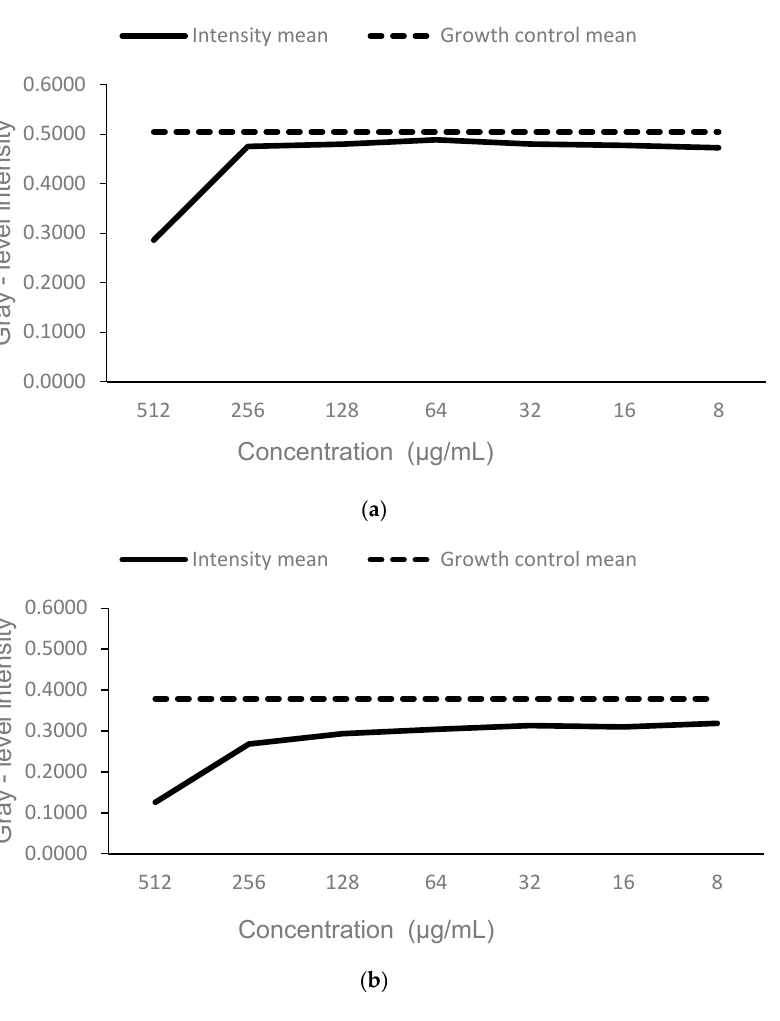
As a result of the information extraction process from each well in Figure 3, gray level intensity matrices were obtained, which are represented in Tables 1 and 2.